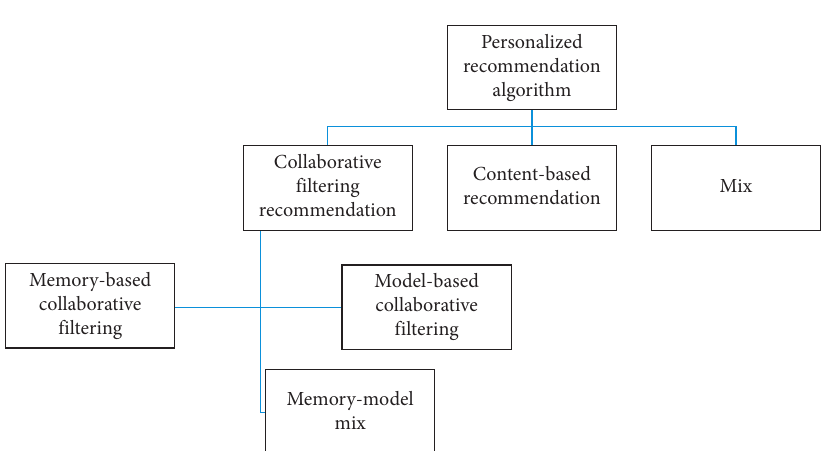
Figure 2: Various types of common collaborative filtering